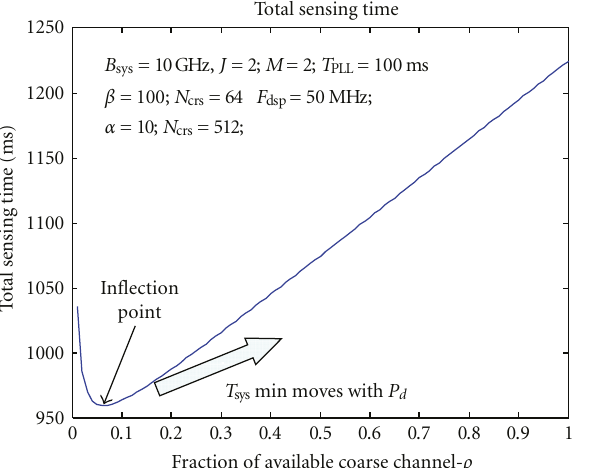
Figure 3: Total mean sensing time versus fraction of available coarse channels.